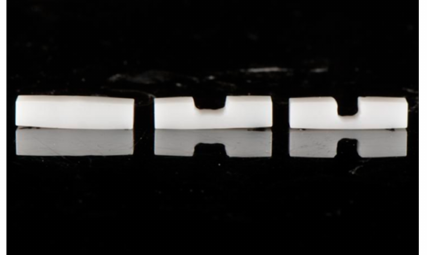
Figure 2. Samples abraded to 1.5 mm and 1 mm residual thickness.